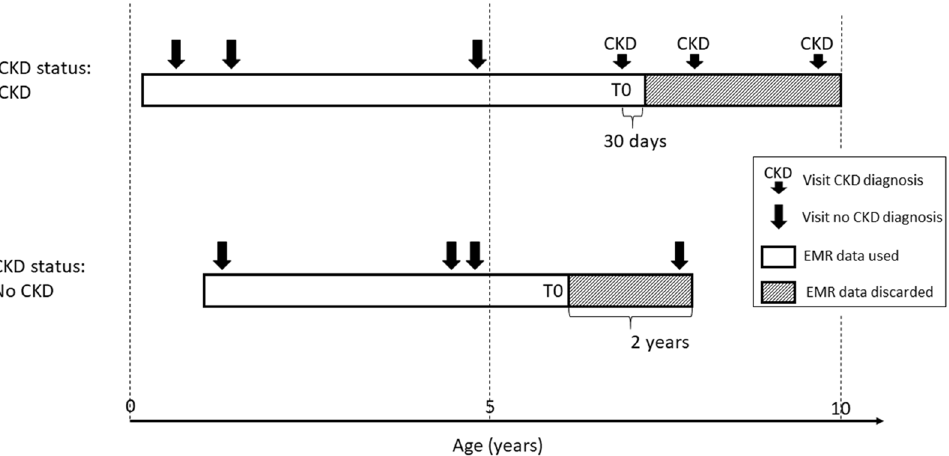
Figure 2. Schematic representation of CKD status assignment, EHR data use, and reference time T0 scaling for 3 hypothetical dog EHR profiles. CKD, chronic kidney disease; EHR, electronic health